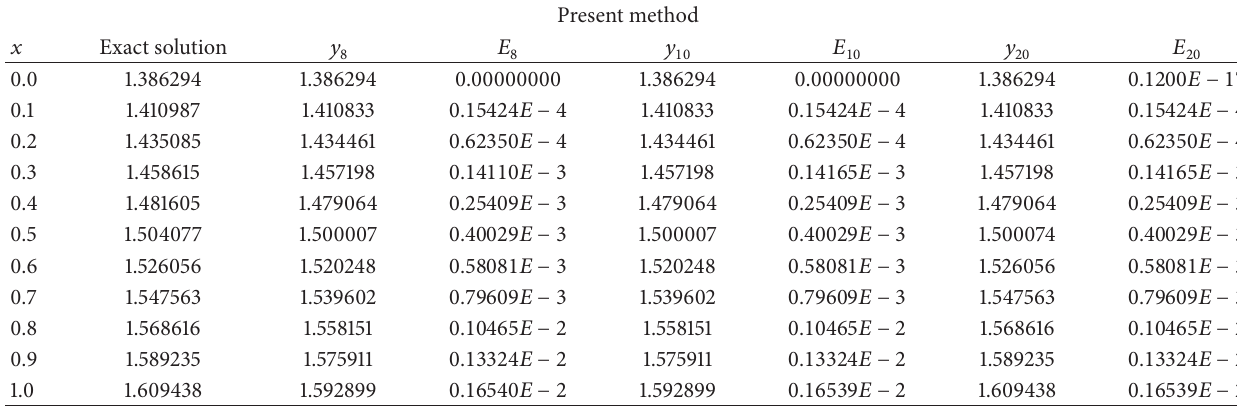
Table 5: Numerical solution and absolute error of Example 6 for different 𝑁 values.